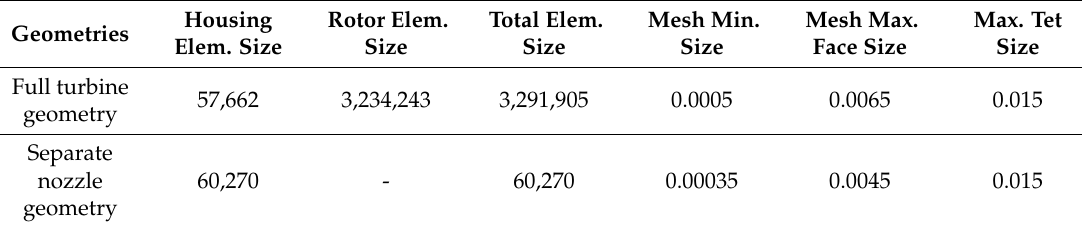
Figure 9. Model mesh validation: ( a ) full turbine model; ( b ) separate nozzle model. Table 3. Meshing size details of the full turbine geometry and separate nozzle geometry.